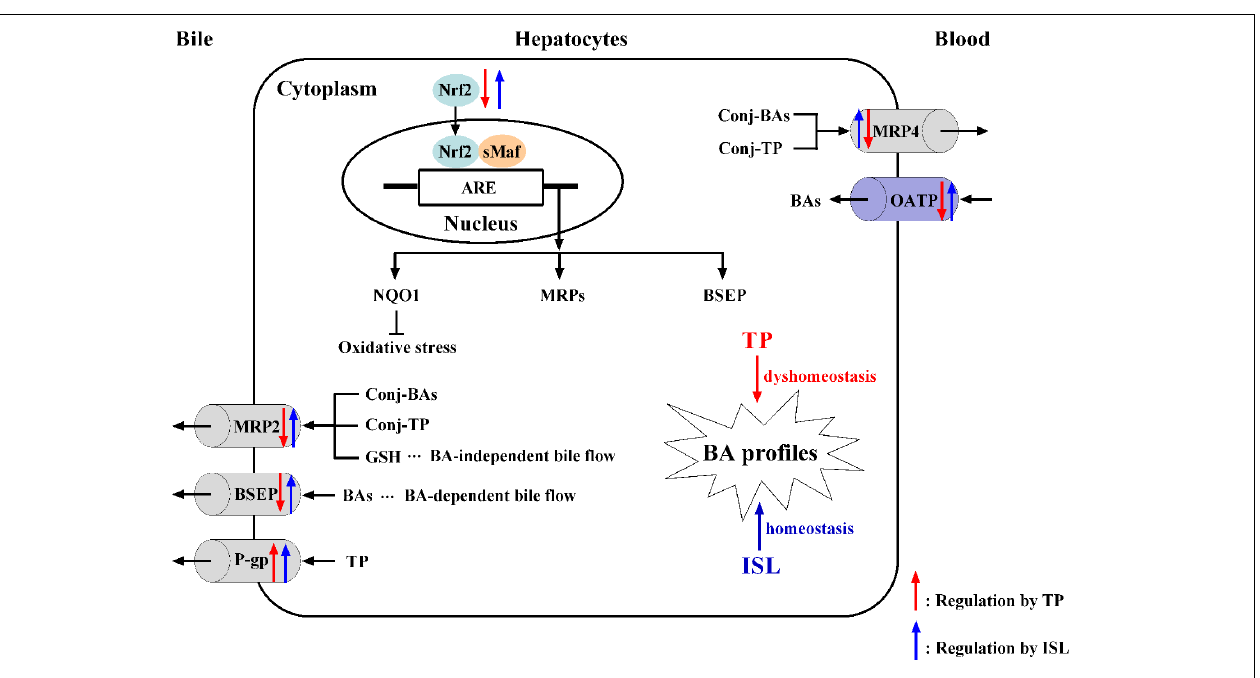
FIGURE 9 | The proposed mechanism of TP-induced hepatotoxicity and ISL combined treatment protecting against TP-induced liver injury. ARE, antioxidant responsive element; BA, bile acid; BSEP, bile salt export pump; conj, conjugated; GSH, reduced glutathione; ISL, isoliquiritigenin; MRP, multidrug resistance protein; NQO1, NAD(P)H: quinine oxidoreductase 1; Nrf2, nuclear transcription factor E2-related factor 2; OATP, organic anion transporting polypeptide; P-gp, P-glycoprotein; sMaf, small Maf proteins; TP,